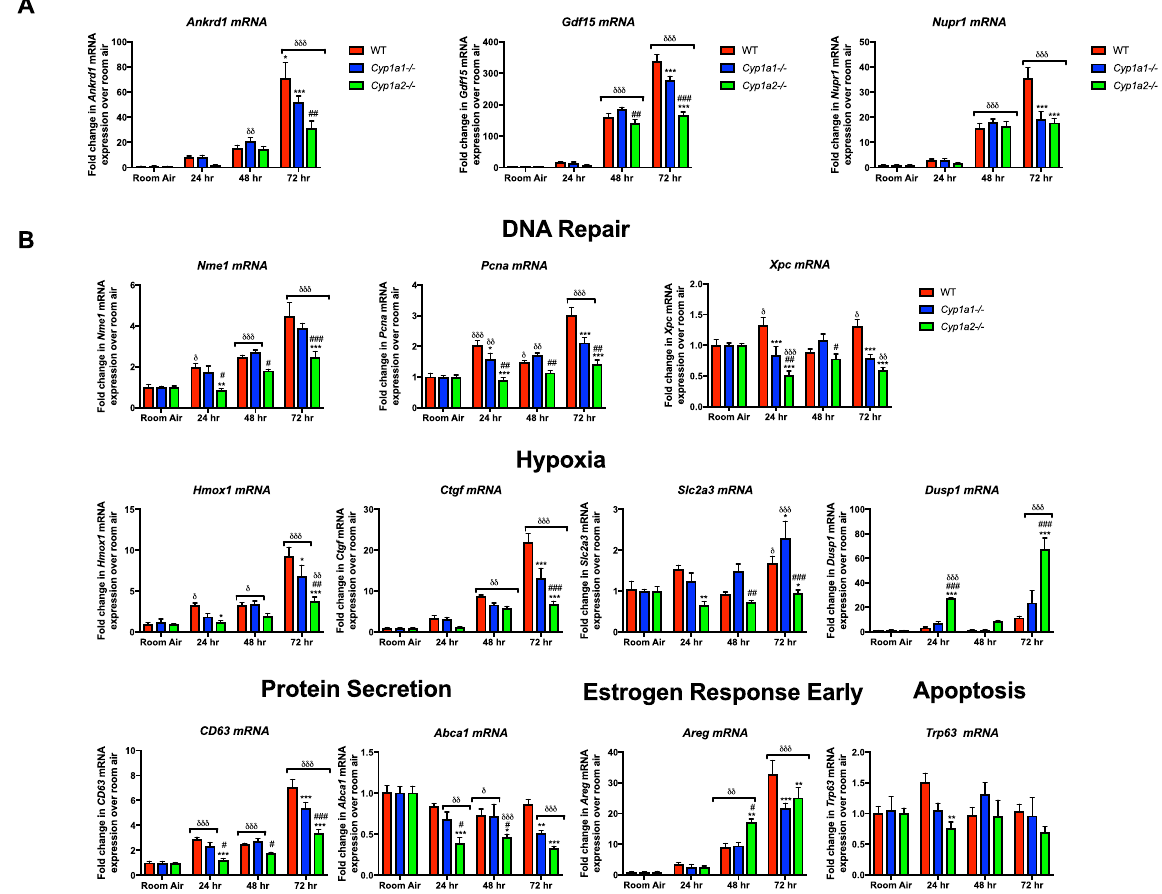
Figure 6. Real time RT-PCR analysis of mRNA from the lungs of WT, Cyp1a1 and Cyp1a2 − / − mice exposed to room air or hyperoxia for 24, 48 or 72 h shows differential regulation of gene targets among WT Cyp1a1 and Cyp1a2 − / − mice. Fold change over room air levels are represented on the y-axis. Two way ANOVA was used to assess statistical significance in adduct levels among genotypes and the effect of hyperoxia. ( A ) Differences in expression of Ankrd1 , Gdf15 and Nupr1 ; genes identified to be upregulated among all three genotypes upon exposure to hyperoxia. ( B ) Differential expression of genes within pathways that were differentially modulated between WT and Cyp1a1 − / − or Cyp1a2 − / − mice. Significant differences in expression compared to levels in WT mice are represented by * p < 0.05, ** p < 0.01 and *** p < 0.001. Significant differences between Cyp1a1 − / − and Cyp1a2 − / − mice are represented by # p < 0.05, ## p < 0.01 and ### p < 0.001. Significant differences from room air levels are represented by δ p < 0.05, δδ p < 0.01 and δδδ p <